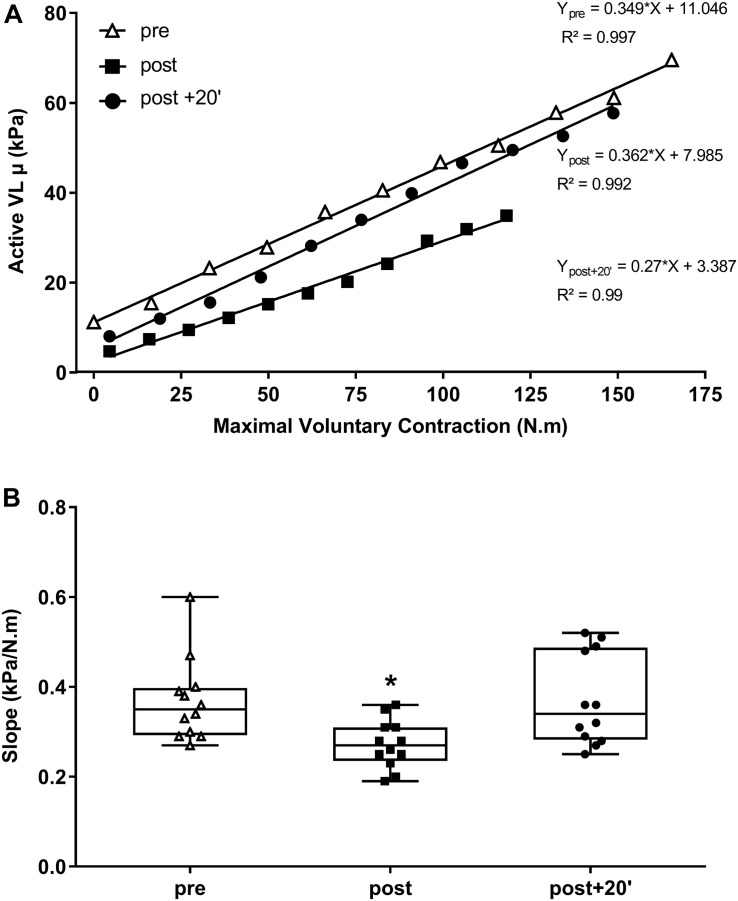
Active vastus lateralis (VL) muscle shear modulus (μ) and absolute torque relationship of the knee extensor muscles evaluated before and after exercise and during the recovery period (post + 20’). Regression equations and correlation coefficients are presented for each relationship (A). The mean of the slope for each time point and individual values are given (B). Mean ± SD (B). *P < 0.05, significant differences from pre-exercise (pre) values.